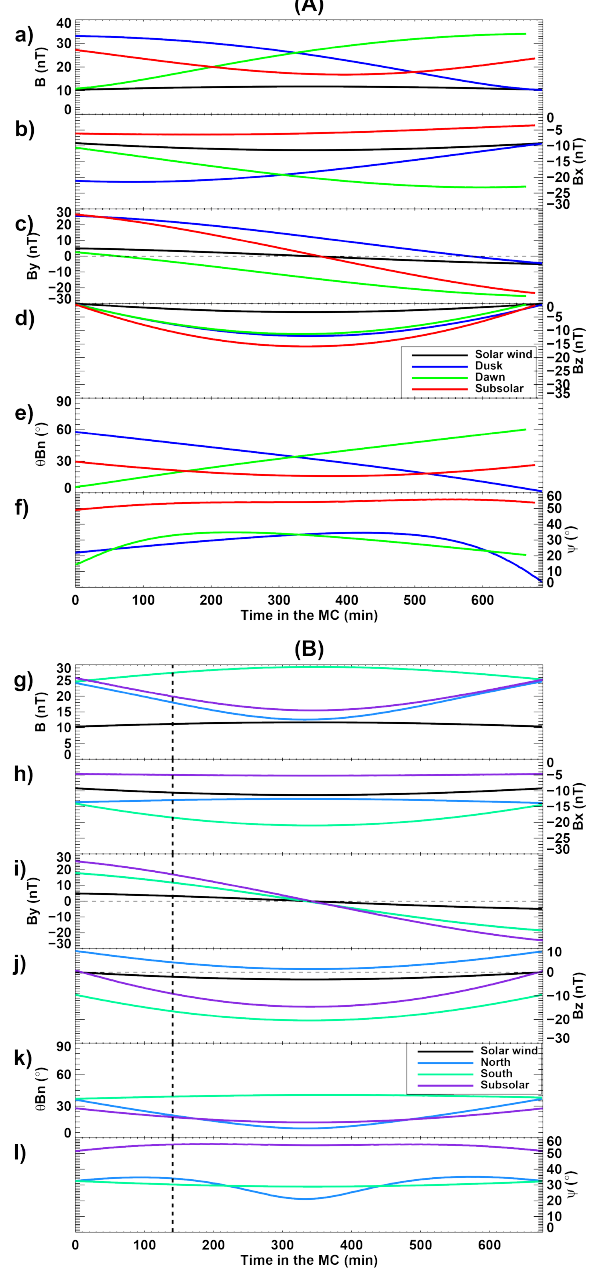
Fig. 7. Virtual spacecraft observations of the magnetosheath mag- netic field during an MC encountered far from its central axis, in the XY plane (A) and in the XZ plane (B) – spacecraft in (A) see the caption of Fig. 6 – spacecraft in (B) in the subsolar magnetosheath (purple), on the northern flank (light blue), on the southern flank (spring